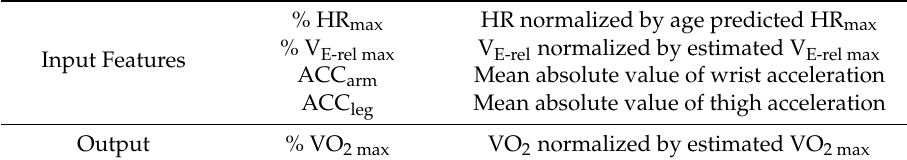
Table 2. Summary of the input features and the output of the neural network.